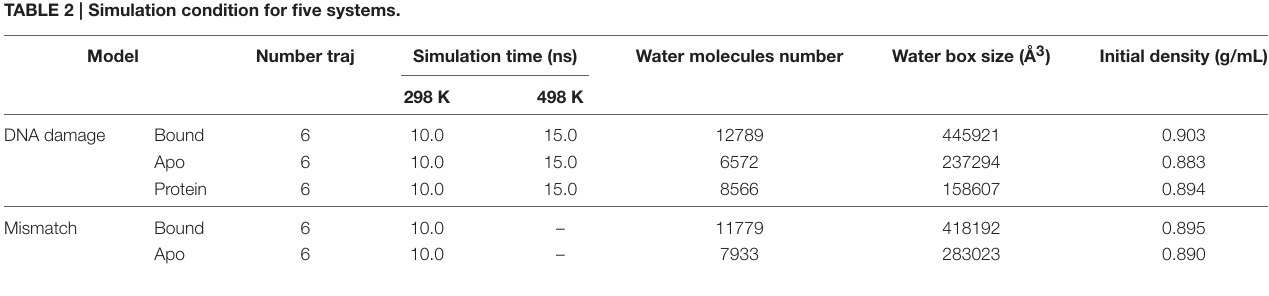
TABLE 2 | Simulation condition for five